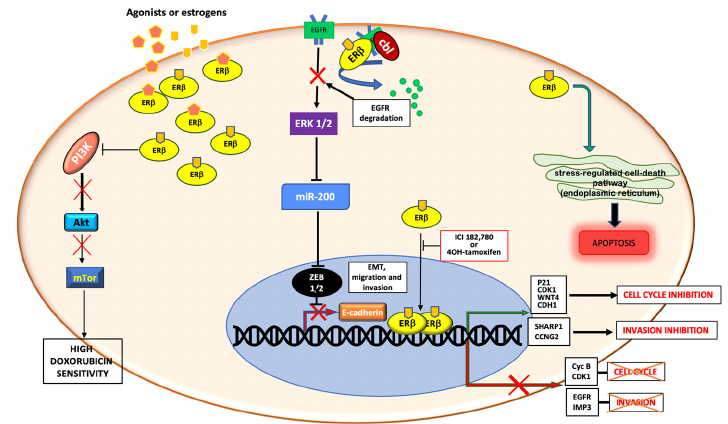
Figure 2. Schematic representation of genomic and non-genomic actions of ER β in TNBC. ER β controls genomic and non-genomic actions upon ligand binding. It is able to control cell cycle and cell migration and invasion by upregulating or downregulating the transcription of different genes. Cytoplasmic ER β rapidly activates the stress-regulated cell death pathway or inhibits the PI3K/Akt/mTor pathway or stimulates the EGFR degradation, thus promoting apoptosis, increasing the doxorubicin sensitivity and inhibiting the EMT transition and cell invasion, respectively.